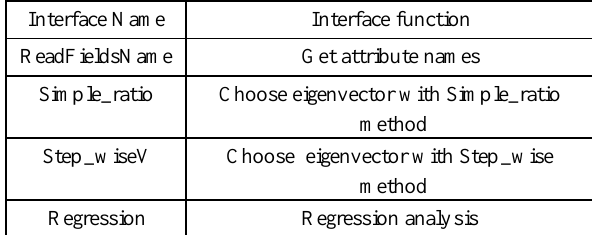
Table 3. Introduction for the Ceigenfunction interface and